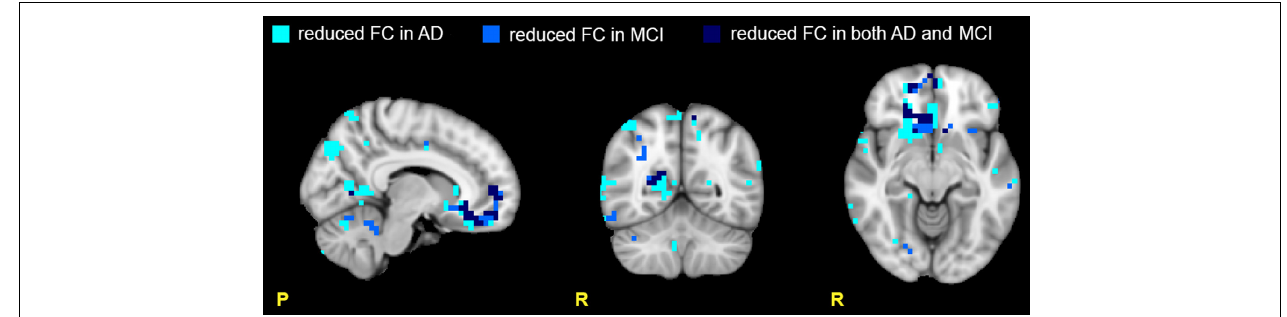
FIGURE 2 | Areas with reduced FC in the RSNs. Images show areas with reduced FC ( p ≤ 0 . 05, TFCE-corrected) in AD compared to HC (light blue), in MCI compared to HC (blue), and in both AD and MCI compared to HC (dark blue). Note that the areas of reduced FC are